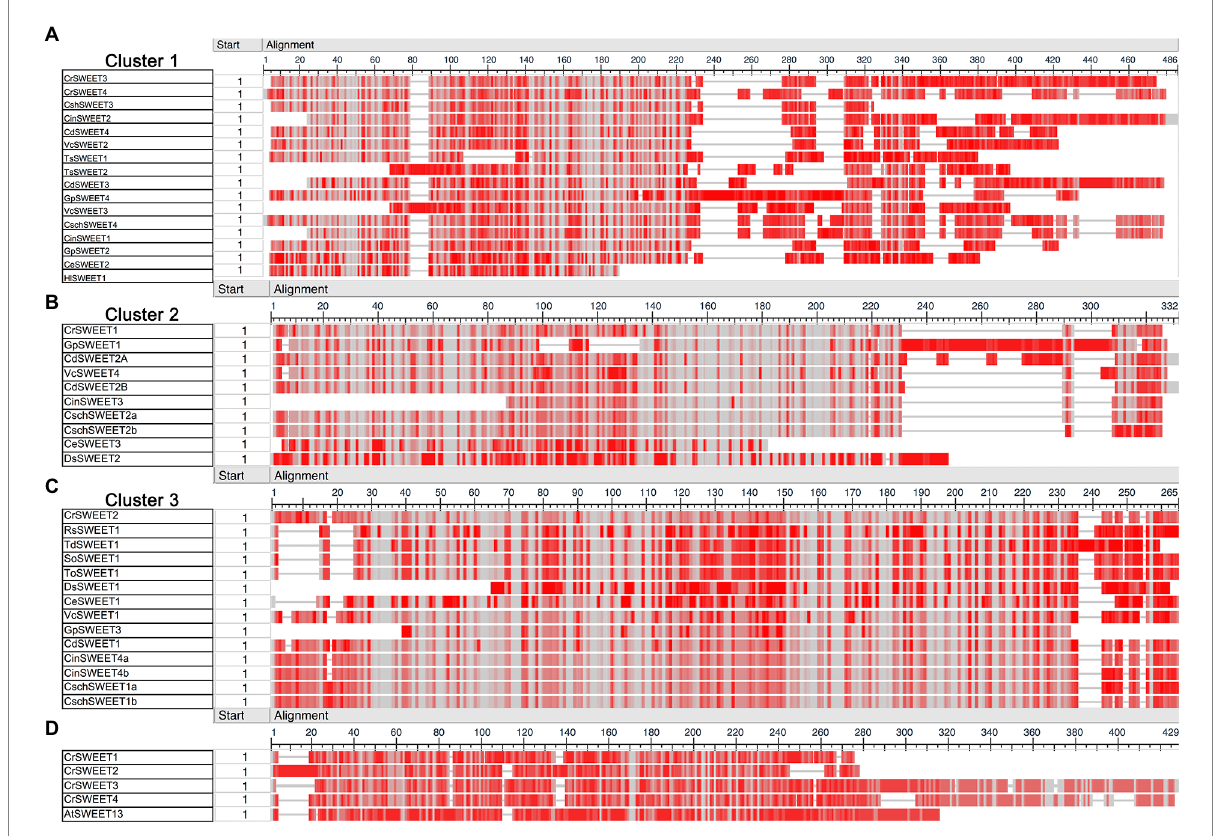
FIGURE 3 (A–C) COBALT multiple sequence alignment of Cluster 1 (A) , Cluster 2 (B), and Cluster 3 (C) algae SWEET protein sequences. (D) Comparison of AtSWEET13 with CrSWEET1 to 4. Amino acid conservation was scored based on frequency within each amino acid position (column). Grey shading indicates and identical residue at that position and darker shades of red indicate differences from residues in other rows in the alignment at that